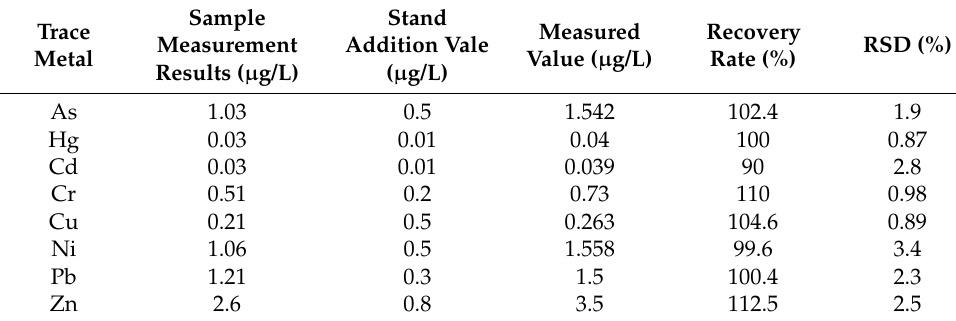
Table A6. Label recovery results (water).